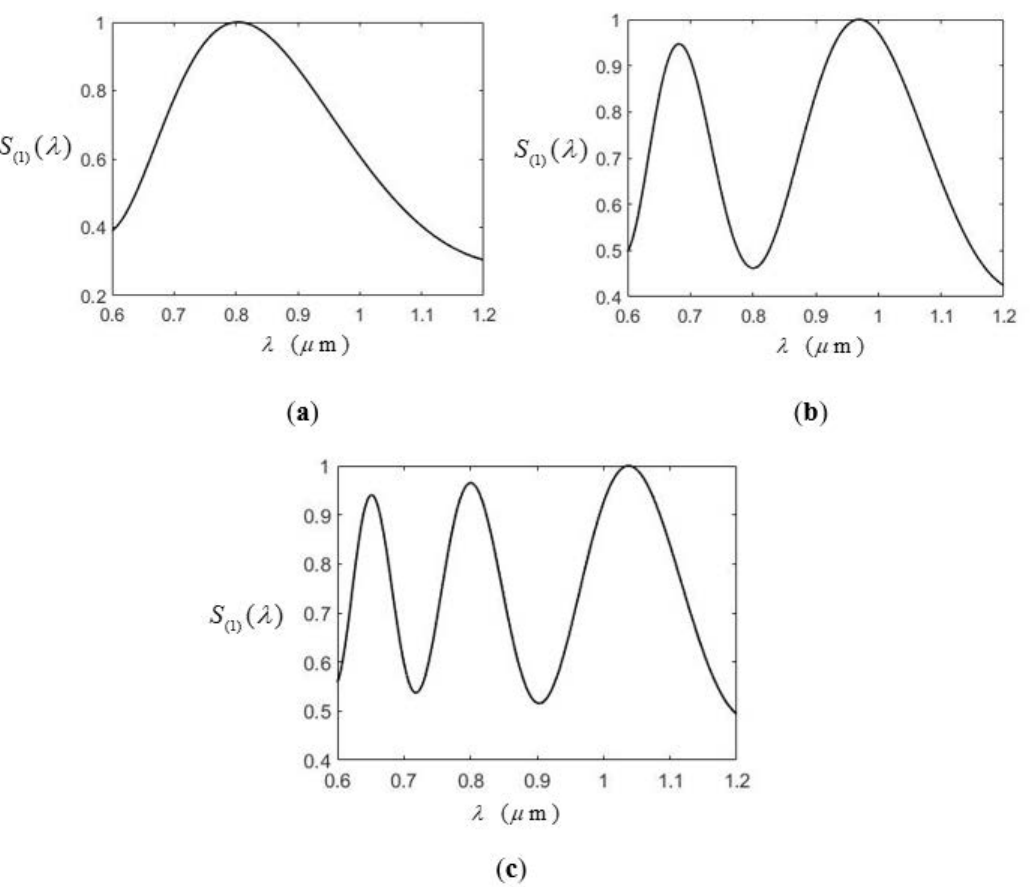
( , ) S x  for three slit width at z = 0.1 μm : ( a ) a = 1.2 μm ; ( b ) a = 2.4 Figure 8. The distribution (1) Figure 8. The distribution S ( 1 ) ( λ , x ) for three slit width at z = 0.1 µ m: ( a ) a = 1.2 µ m; ( b ) a = 2.4 µ m; ( , ) S x  are 1.58, 1.44, and μm ; and ( c ) a = 3.6 μm . The spectrum maximums used to normalize and ( c ) a = 3.6 µ m. The spectrum maximums used to normalize S ( 1 ) ( λ , x ) are 1.58, 1.44, and 1.37 in (1) ( a – c ), respectively. 1.37 in ( a – c ), respectively.